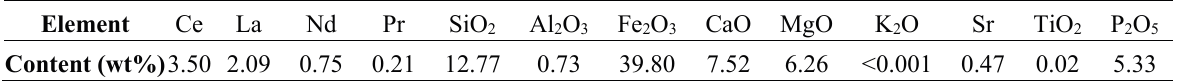
Table 1. Elemental analysis of monazite-bearing ore used in this study.